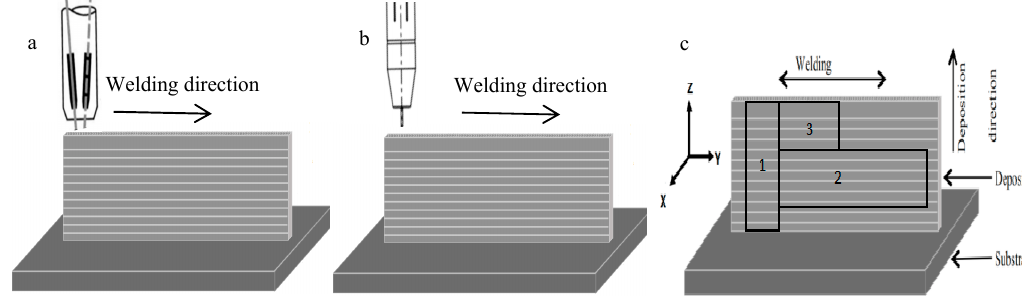
Figure 1. Schematic of the additive manufacturing system and sampling locations. ( a ) Schematic diagram of double-wire process; ( b ) schematic diagram of single-wire process; ( c ) sampling locations.